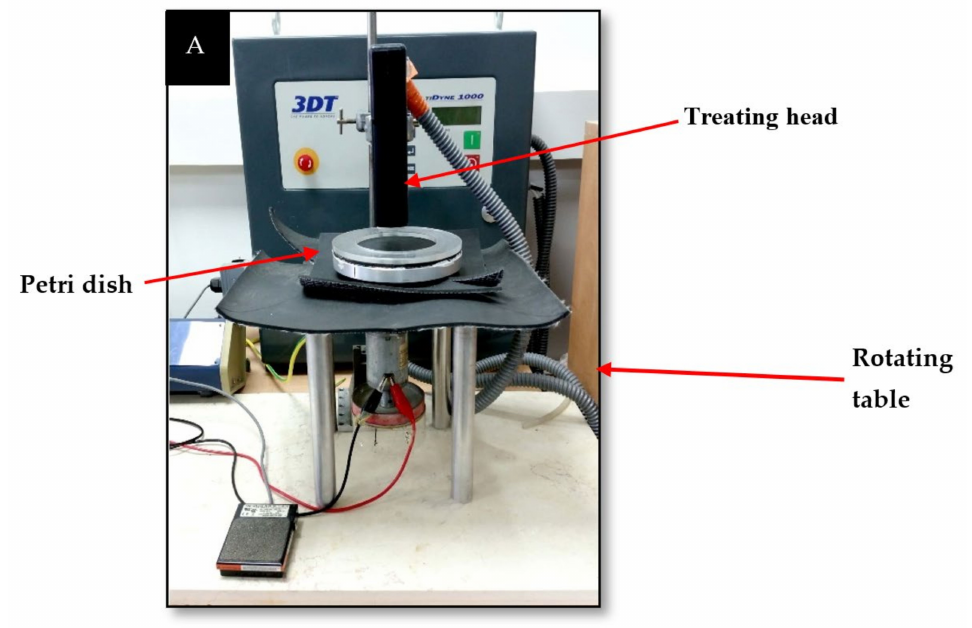
Figure 1. Plasma corona discharge